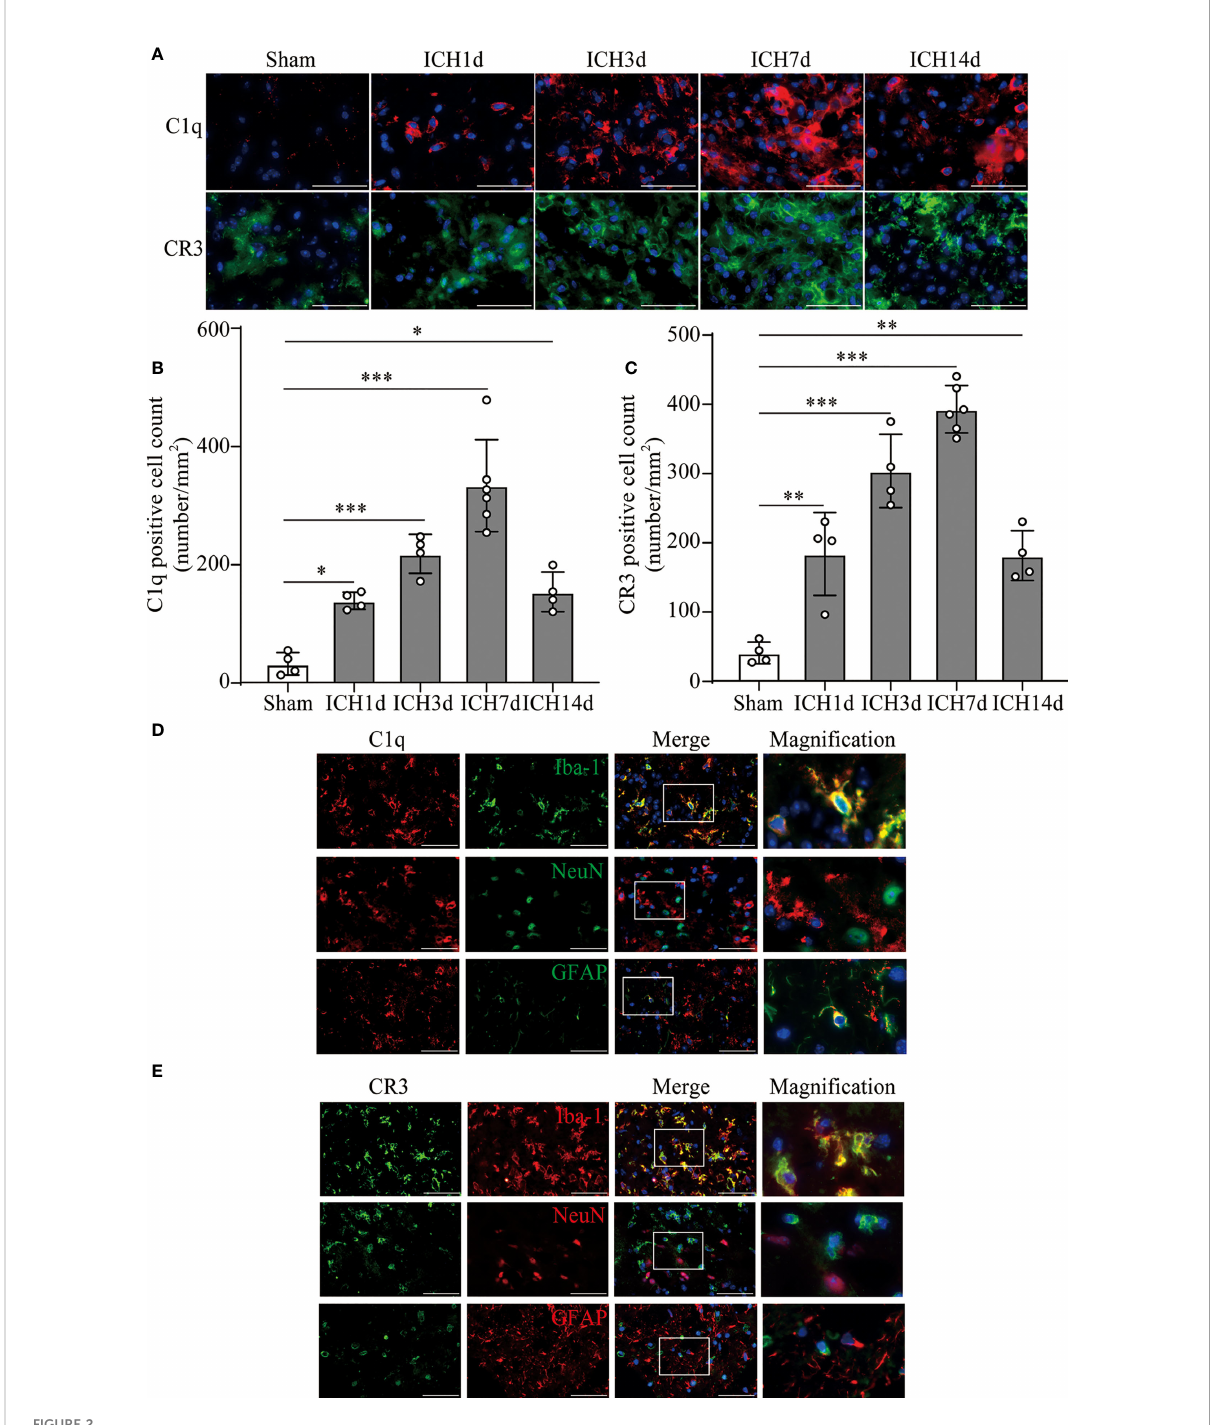
FIGURE 2 The activation of C1q and CR3 after ICH. (A – C) Representative immuno fl uorescent image and quantitative analysis of C1q and CR3 after ICH. n = 4 in the Sham, ICH1d, ICH3d, and ICH14d groups and n = 6 in the ICH7d group. *P <0.05, **P <0.01, ***P <0.001 by one-way ANOVA. ( D, E ) Representative microphotographs of immuno fl uorescence double staining showing the localization of both CR3 and C1q with Iba-1 (microglia marker), NeuN (neuronal marker), and GFAP (astrocyte marker) after ICH3d. n = 3. Scale bar = 50 m m. Data are represented as mean ±